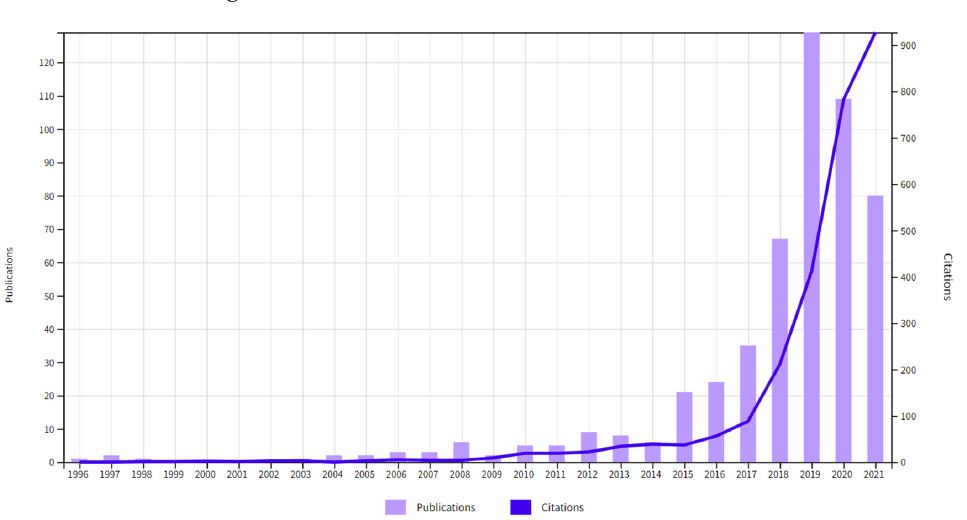
Figure 14. Trend and citation structure.